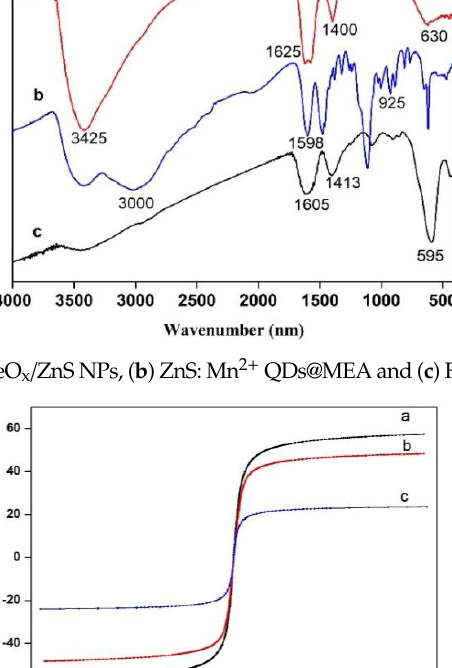
( b ) Figure 2. TEM images of ( a ) FeO x /ZnS NPs and ( b ) FeO x /ZnS@MIPs. The structure of ZnS: Mn 2+ QDs@MEA, FeO x @COOH and FeO x /ZnS NPs was analyzed by FT-IR spectroscopy. As shown in Figure 3, the characteristic Fe – O bands were present in FeO x /ZnS (632 cm − 1 ) and FeO x @COOH MNPs (594 cm − 1 ), respectively. Peaks at 1598 cm − 1 (amino groups), 925 cm − 1 (bending vibration) and the disappeared peaks at 2550 – 2670 cm − 1 (S – H thiol group) in the curve b